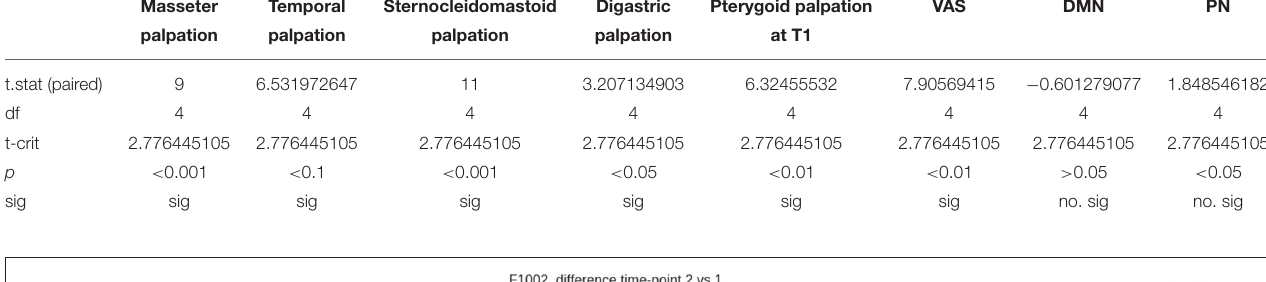
TABLE 4 | Statistical results.